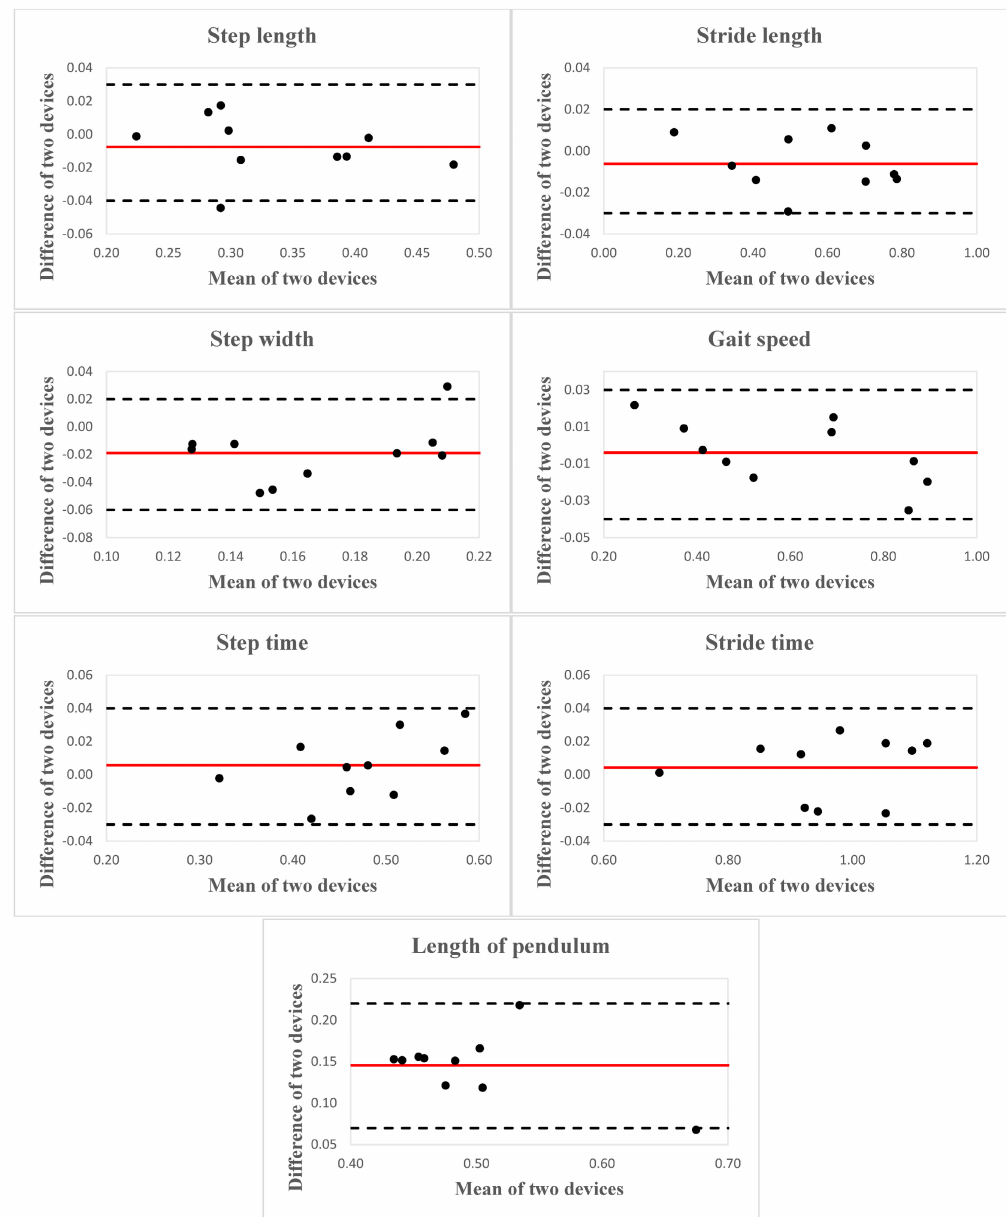
Figure 4. Bland–Altman plots indicate the agreement between gait spatiotemporal variables for ten children with CP calculated using the Kinect V2 and Motion Analysis. The red solid line represents the reference line at the mean, and the two black dashed lines represent the upper and lower limit of